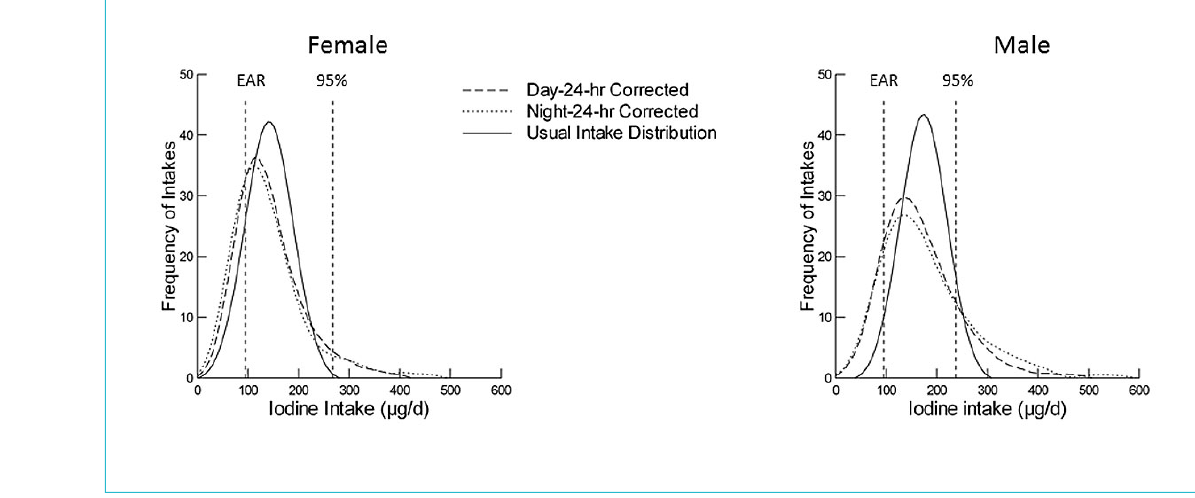
Figure 3: Application of US National Cancer Institute method to estimate the usual iodine intake distribution for all women and all men in the study population. Cut-off lines are drawn to indicate the estimated average requirement (EAR; 95 µg/d) for both female and male and the top 5% of the intake distribution (268 and 237 µg/d for females and males, respectively); the tolerable upper intake level is 1100